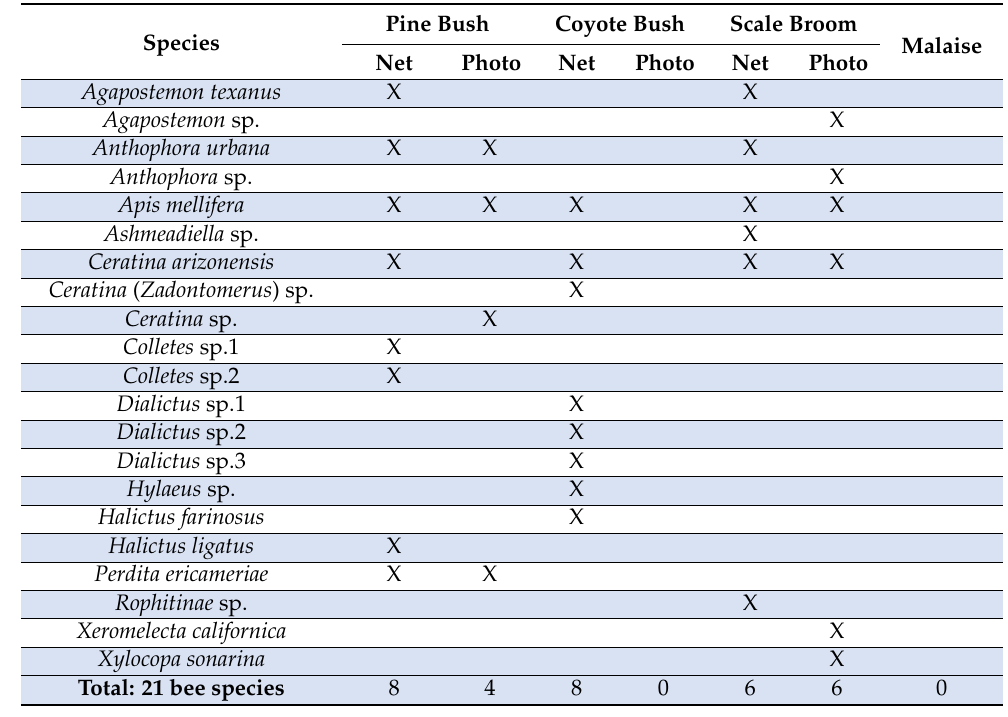
Table 4. Butterflies of E. pinifolia (pine bush), B. pilularis (coyote bush), and L. squamatum (scale broom). Pine Species